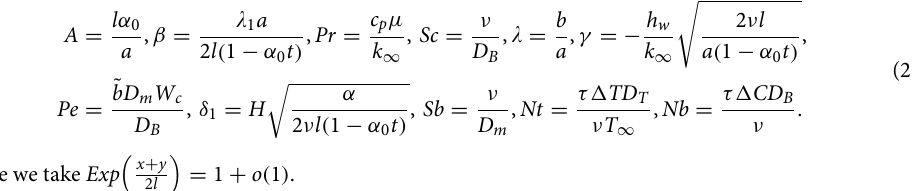
x + y = 1 + o ( 1 ) . 2 l (cid:31) (cid:30)